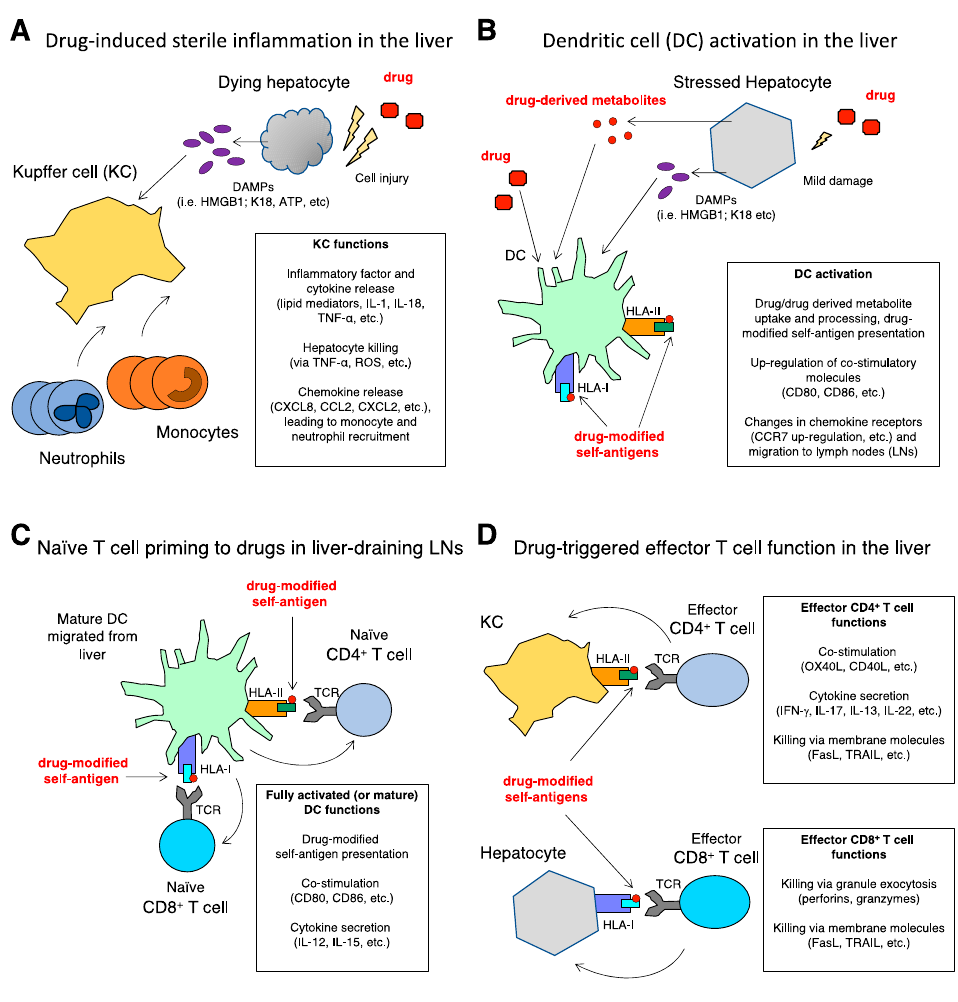
Figure 1. ( A – D ) Innate and adaptive immune responses in DILI. Examples of immune-mediated mechanisms are illustrated (see text for more details). (A) Drug-induced sterile inflammation in the liver. Drug-mediated injury of hepato- cytes is followed by the release of DAMPs that are sensed by Kupfer cells (KCs) which, in turn, start the inflammatory process characterized by the recruitment of neutrophils and monocytes from the blood. Both lipid mediators and cytokines sustain the inflammation. Hepatocyte killing by cells of the innate immunity contributes to liver damage and amplifies the inflammatory loop. A proto-typical example of drug-induced sterile inflammation is that occurring in APAP-DILI; in this scenario, inflammation can be inhibited by neutralization of HMGB1, one of the DAMPs released by hepatocytes [14,21,27]. (B) Dendritic cell (DC) activation in the liver. DAMPs released from injured hepato- cytes activate DCs, which up-regulate co-stimulatory molecules, take up drugs and/or their metabolites, and present drug-modified self-antigens in the context of HLA-I and HLA-II. Activated DCs modulate chemokine receptors expression and migrate to liver- draining lymph nodes (LNs) wherein they can induce a drug-specific T cell response. In vitro results support the depicted mechanisms, for example by showing monocyte-de- rived DC activation after incubation with DAMPs released by primary human hepato-